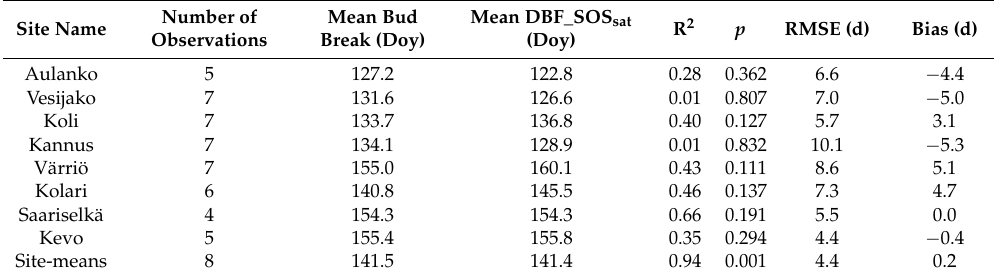
Table 2. Comparison between DBF_SOS sat and phenological observations of bud break of birch for sites in Finland. A positive bias means that the detected SOS is late compared to observations.